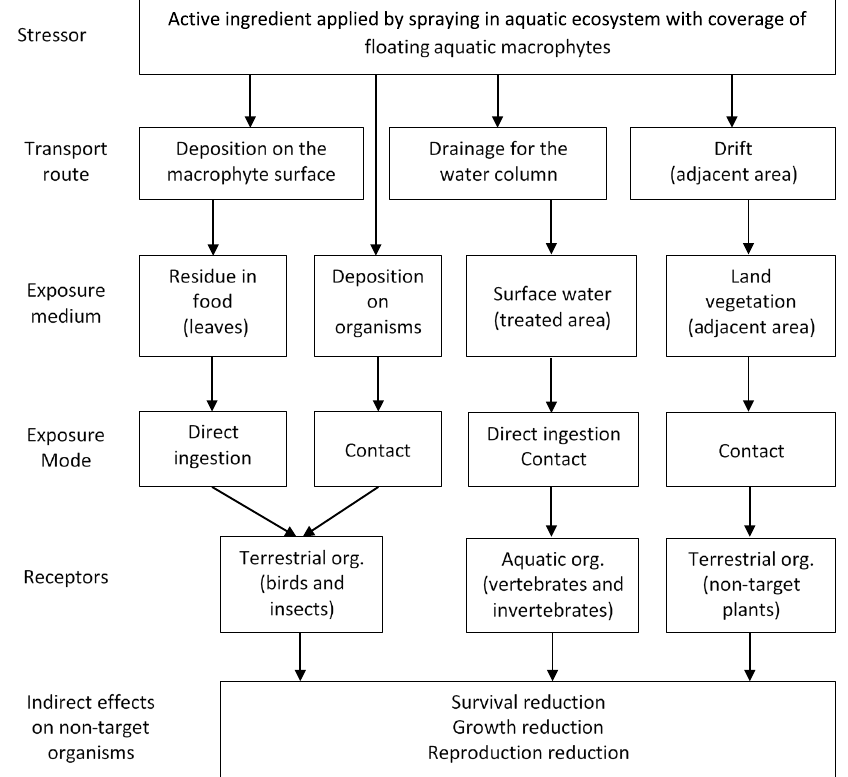
Figure 1. Diagram of the conceptual model describing the environmental risk related to the glyphosate use to control floating aquatic